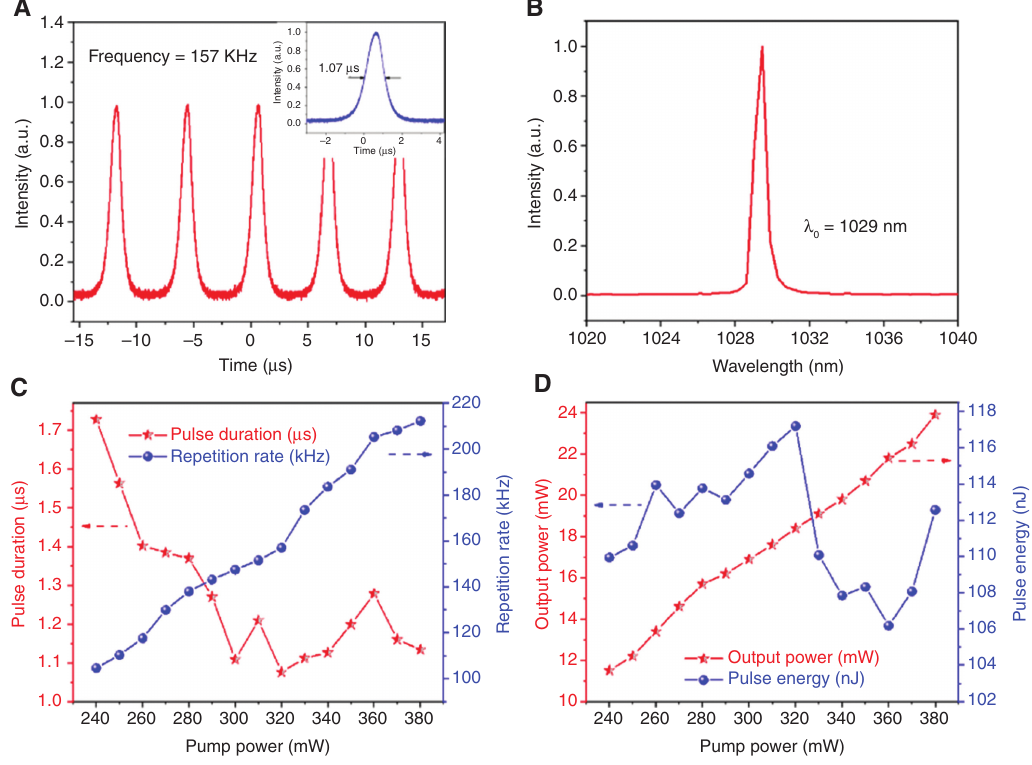
Figure 4: The results of Q-switched YDFL. (A) Q-switched pulse width at the pump power of 320 mW. (B) Optical spectrum. (C) Pulse repetition rate and pulse duration vs. pump power. (D) Single-pulse energy and average output power vs. pump